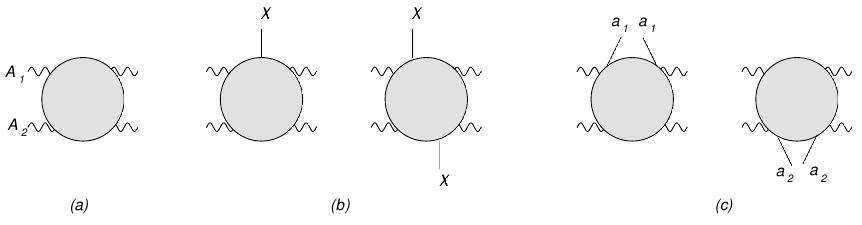
Figure 7 . Vertex functions. (a) elastic process (b) emission of one or two (cid:31) (cid:12)elds (c) emission of a 1 or a 2 ).